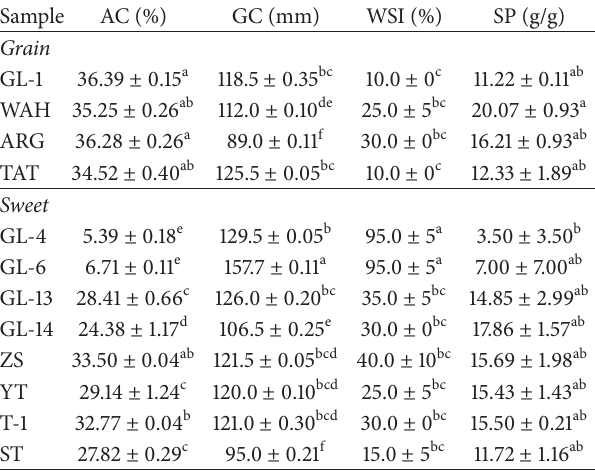
Table 2: Amylose content (AC), gel consistency (GC), water solubility index (WSI), and swelling power (SP) for starches from sweet and grain